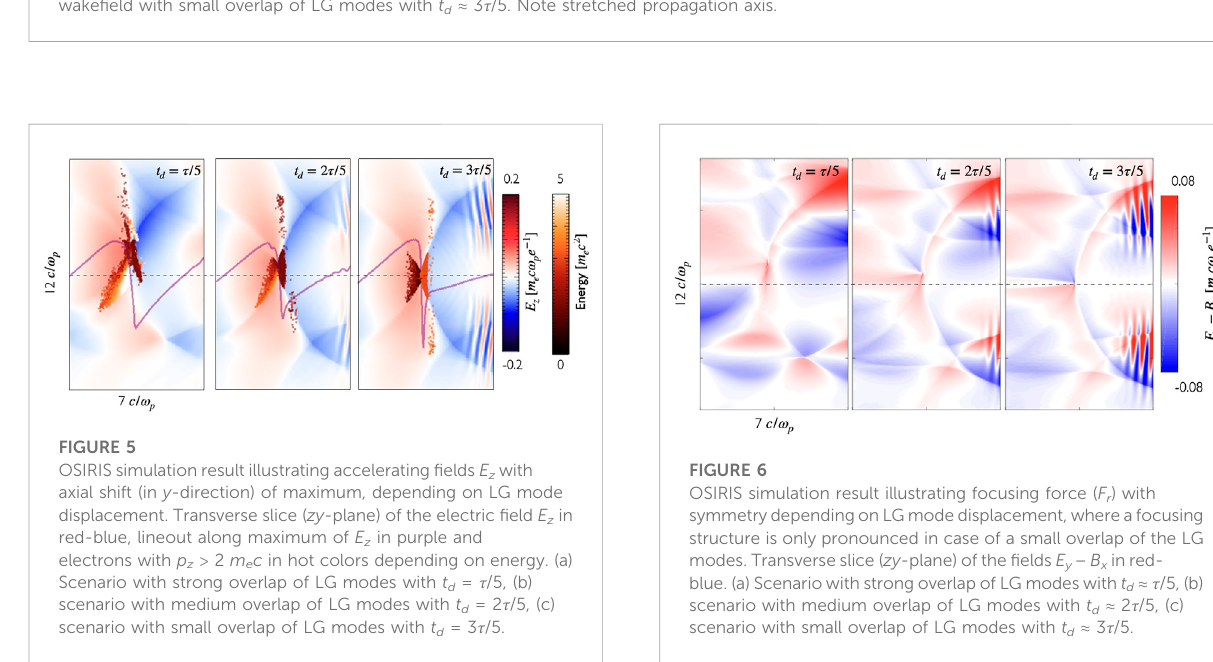
FIGURE 4 OSIRIS simulations of wake fi eld generation with self-torque. (Upper panel) Projections show the absolute electron density in grey-scale (white to dark grey). Orange-red colors are the laser fi eld isosurfaces. Green spheres are the accelerated electrons with p z > 2 m e c . (Lower panel) Corresponding p y – p z momentumspaceofforwardacceleratedelectronswith p z > 1.0 m e c .[Left – (A,B) ]Self-torquewake fi eldwithstrongoverlapof LG modes with t d ≈ τ /5. [Middle – (C,D) ] Self-torque wake fi eld with medium overlap of LG modes with t d ≈ 2 τ /5. [Right – (E,F) ] Self-torque